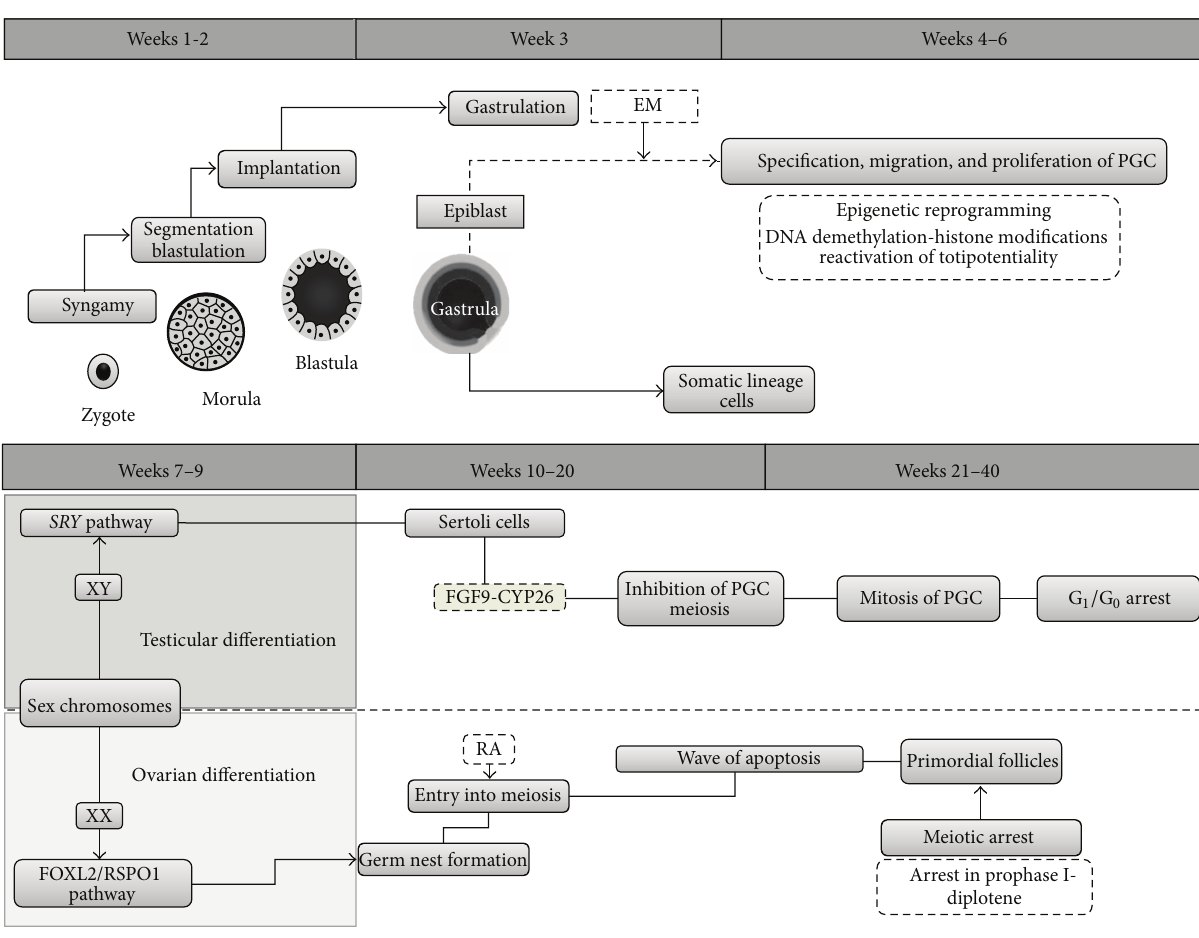
Figure 2: Overview of gonadal differentiation and germ cell development. CYP26: retinoic acid hydroxylases; EM: extraembryonic mesoderm; FGF9: fibroblast growth factor-9; PGC: primordial germ cells. RA: retinoic acid. Syngamy yields a single totipotent cell, the zygote, which subsequently undergoes several proliferative and reorganizational processes. After gastrulation, arrangement into a three-layered embryonic structure , has occurred, nascent PGC undergo induction into pluripotent cells, specification, by EM. PGC also begin migration towards their final residence, the gonadal ridges, whilst simultaneously suffering epigenetic reprogramming essential for reactivation of totipotentiality. Afterwards, according to the sex chromosome load, both PGC and gonads undergo differentiation . In XY subjects, SRY induces differentiation of Sertoli cells, which thereafter drive testicular differentiation. Likewise, FGF9 and RA hydroxylases inhibit meiosis in these PGC, instead favoring mitosis and then cell cycle arrest until puberty. In contrast, in XX individuals it is FOXL2/RSPO1 signaling in ovarian primordia that drives development of female gonads and germ nest formation. RA then induces entry into meiosis and proliferation. These cells later suffer a wave of apoptosis which determines the final pool of primordial follicles, which remain arrested in meiosis I until